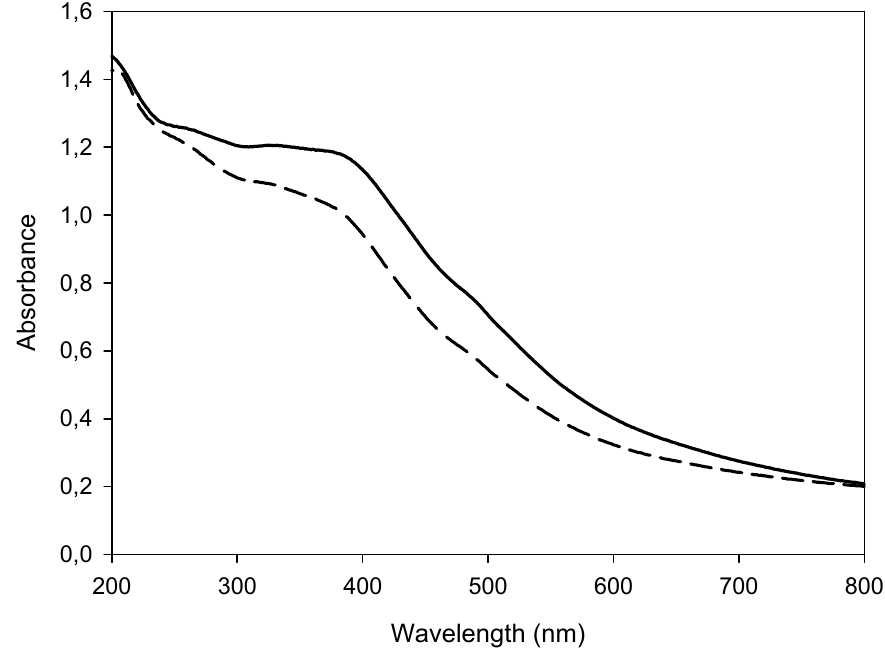
Figure 2. UV-Vis spectra of naked SAMNs and of the SAMN@XO complex. Measurements were carried out in water. Solid line: 0.1 g L − 1 naked SAMNs; Dashed line: 0.1 g L − 1 SAMN@XO. In order to evidence possible modifications of the enzyme catalytic behaviour upon binding, the nanostructured hybrid (SAMN@XO) was kinetically characterized.